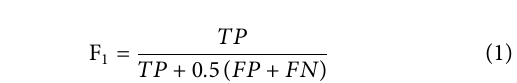
Frontiers in Earth Science |